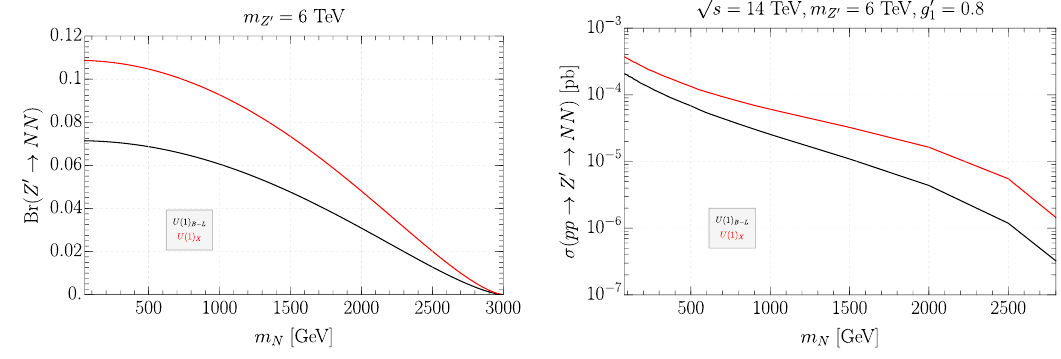
Figure 2 . Left : Br( Z 0 → NN ) vs. m N , for m Z 0 = 6 TeV. Right : the inclusive (i.e., no kinematic cut is imposed) scattering cross section, σ ( pp → Z 0 → NN ) , in picobarn as a function of m N , for m Z 0 = 6 TeV and g 0 = 0 . 8 . 1